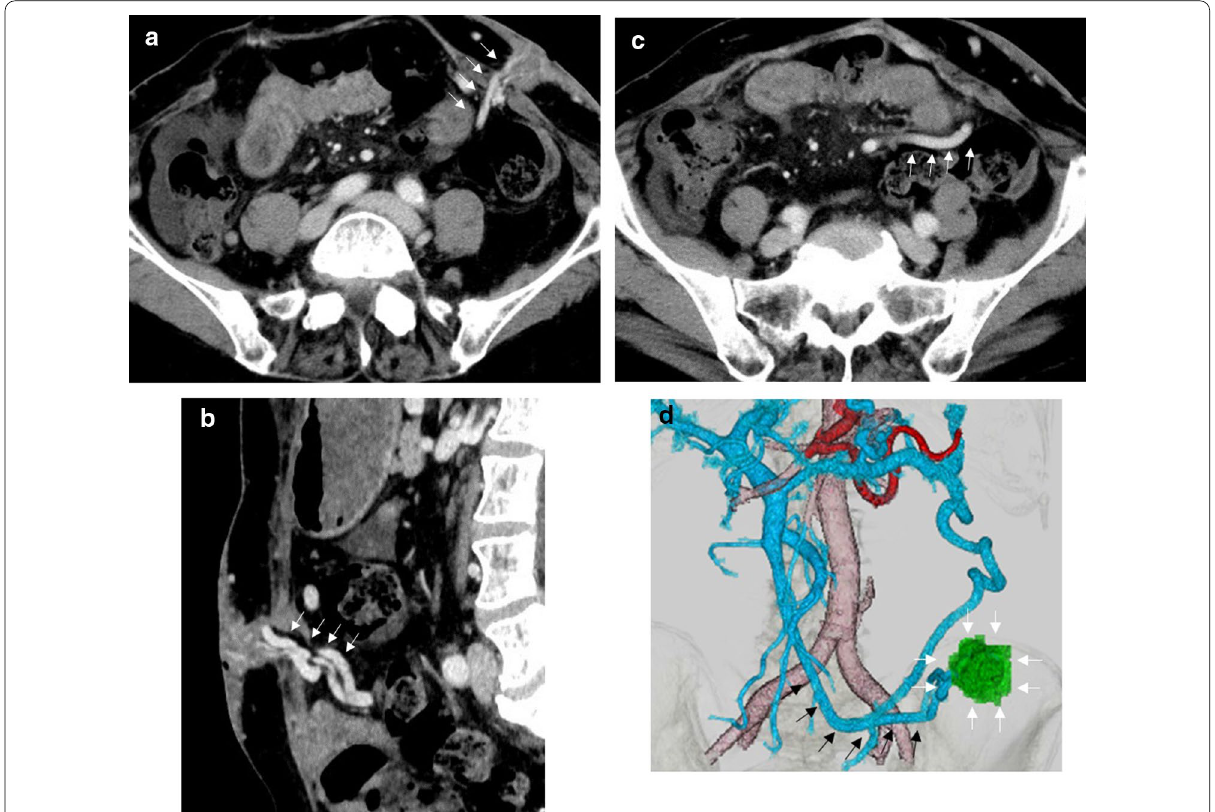
Fig. 2 Abdominal CT imaging. a (horizontal slice), b (sagittal slice) Ectopic varices and collateral vessels at the ileal conduit stoma (arrow). c The varices were fed by superior mesenteric vein (arrow). d Three-dimensional reconstruction showed the ileal conduit stomal varices (white arrow) fed by the superior mesenteric vein (black